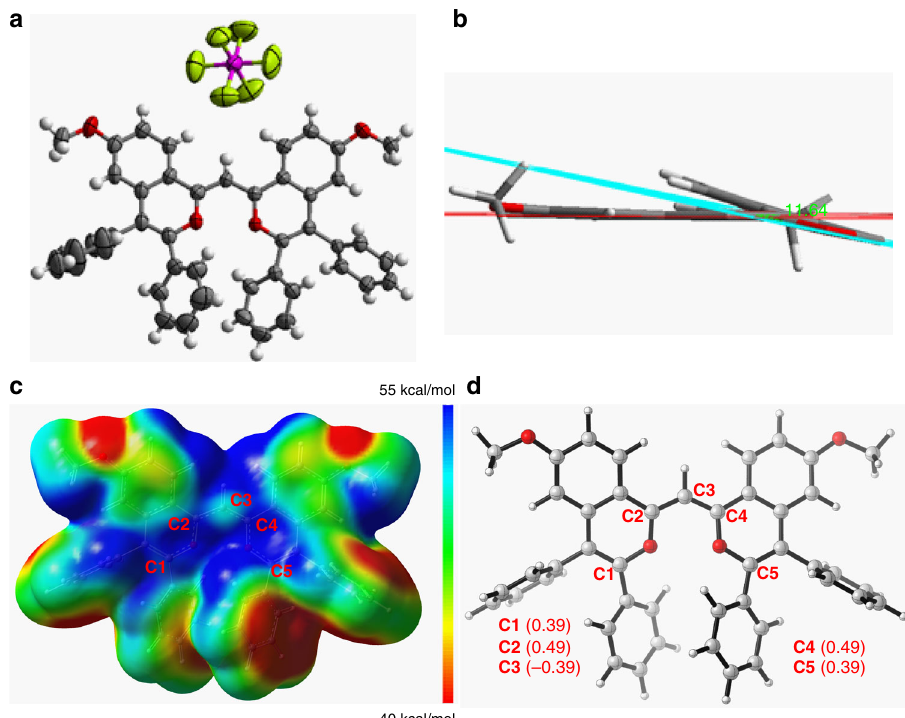
Fig. 3 X-ray single crystal diffraction analysis and DFT calculation of 3aa. a Top view of X-ray single crystal structure of 3aa . b Side view of X-ray single crystal structure of 3aa . c Electrostatic potential maps of 3aa . d Calculated NBO atomic charge distribution of cationic 3aa .